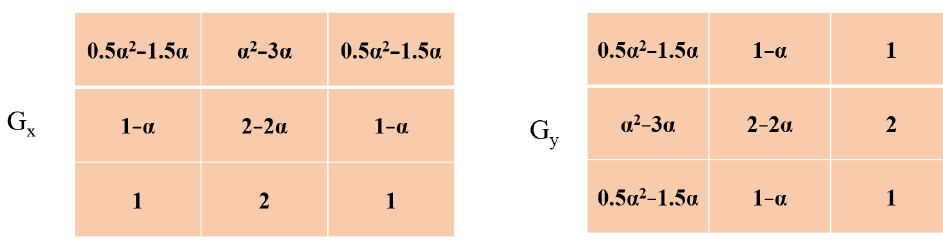
Figure 5. The adapted Sobel representation.